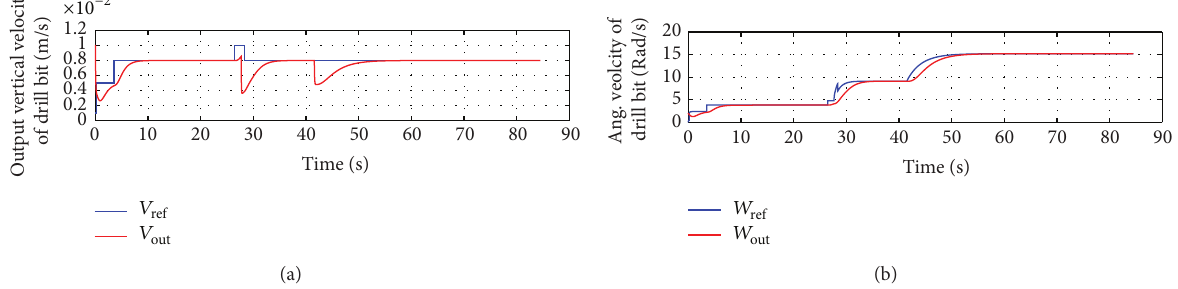
(𝑡) versus reference vertical velocity V out (𝑡) 1𝑑